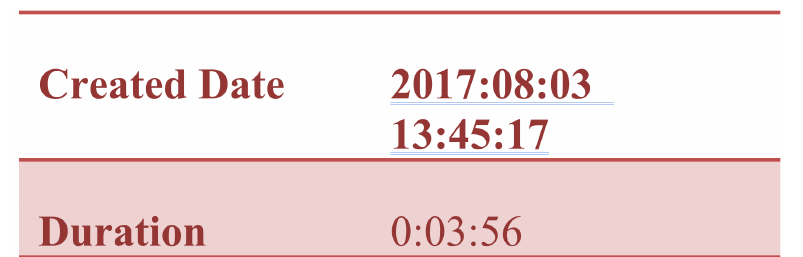
Figure 7. Timestamps and flight duration.